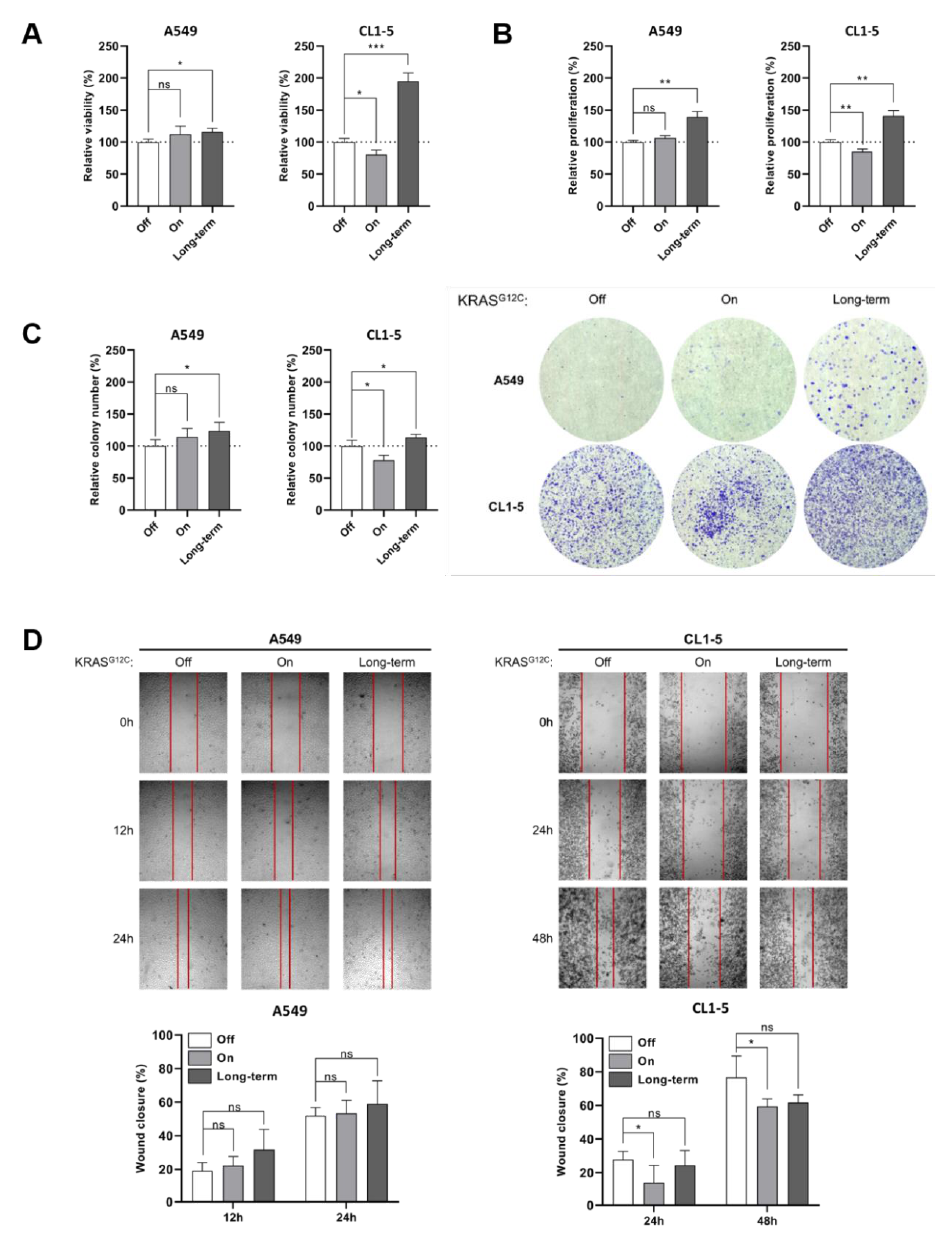
Figure 1. Phenotypic characterization of A549 and CL1-5 KRAS G12C Tet-inducible stable cell lines. ( A ) Cell viability assay using ready resazurin solution and absorbance measurement at 570 nm and 600 nm before the addition of doxycycline (Off) and after short-term (72 h) and long-term (>1 month) induction of KRAS G12C in A549 and CL1-5 cells. All levels are shown as a percentage (%) of relative viability as compared to the control (Off condition for both cases). ( B ) Cell proliferation assay using 0.2% crystal violet in 20% methanol and absorbance measurement at 590 nm before addition of doxycycline (Off) and after short-term (72 h) and long-term (>1 month) induction of KRAS G12C in A549 and CL1-5 cells. All levels are shown as a percentage (%) of relative proliferation as compared to the control (Off condition for both cases). ( C ) Colony-formation assay before addition of doxycycline (Off) and after short-term (72 h) and long-term (>1 month) induction of KRAS G12C in A549 and CL1-5 cells. All levels are shown as a percentage (%) of relative colony number as compared to the control (Off condition for both cases). ( D ) Wound healing assay before addition of doxycycline (Off) and after short-term (72 h) and long-term (>1 month) induction of KRAS G12C in A549 at 12 h and 24 h and in CL1-5 cells at 24 h and 48 h following the wound procedure. Each time-point for each condition was compared to the initial wound at 0 h and the statistical analysis involved the comparison of On and long-term conditions with the Off condition. All levels are shown as a percentage (%) of wound closure as compared to the control (0 h). Data are compared by using unpaired Student’s t -test and are presented as means ± SD of biological triplicates. P -values are indicated with * p < 0.05; ** p < 0.01; *** p <